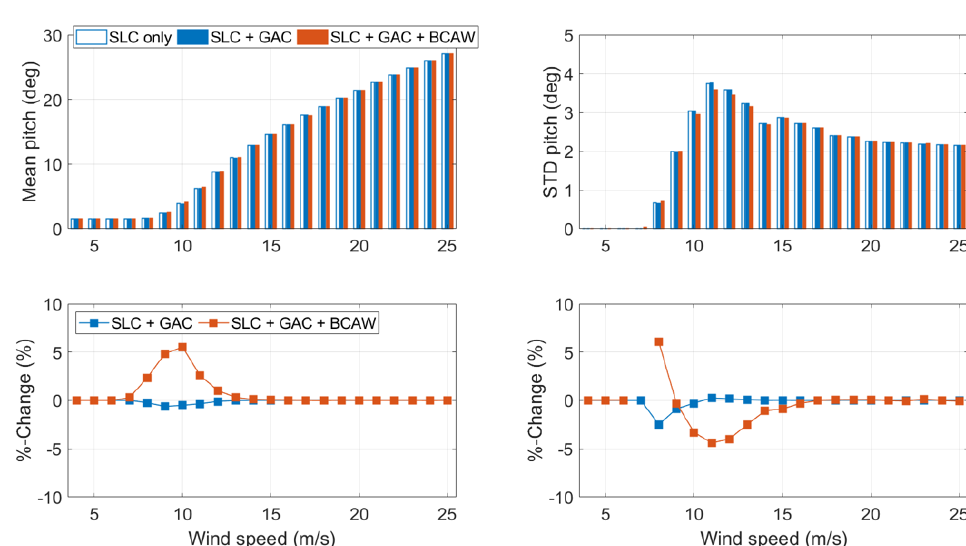
Figure A3. Variation of the mean and standard deviation of the pitch from cut-in to cut-out wind speed under DLC 1.2 with different control architectures. Top—Dimensional values; Bottom— Percentage changes with respect to the ‘SLC Only’